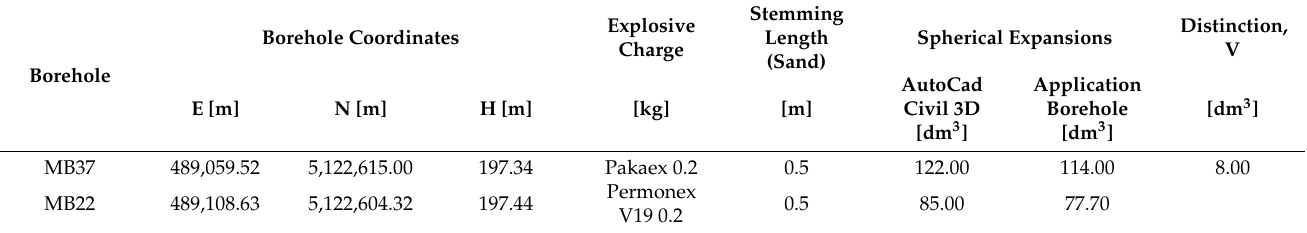
Table 2. Examples of the boreholes from the work site and the distinction between application Borehole and AutoCAD Civil 3D